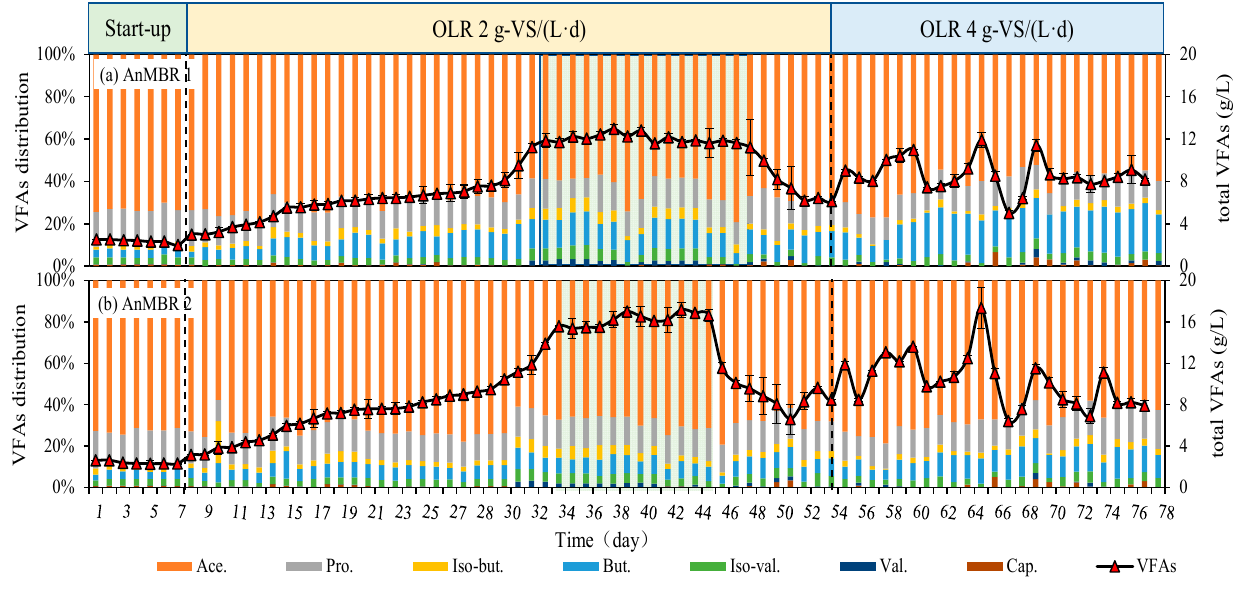
Figure 2. Changes in the VFA production and distribution in the ( a ) AnMBR1 and ( b ) AnMBR2. Regardless of the stage of fermentation, loading rate or pH, acetic, propionic and butyric acids were the most abundant VFA (Figure 2), of which, acetic acid formed the highest VFA fraction (65–70%), followed by propionic acid (about 10%) and butyric acid (5–10%). This result was consistent with the results acquired in batch assays using CM [20]. pH is one of the key factors controlling metabolic pathways and ultimately deter- mining the distribution of VFA [36]. Butyric acid and propionic acid are reported to be dominant at low pH, while acetic acid becomes the main metabolic product at high pH